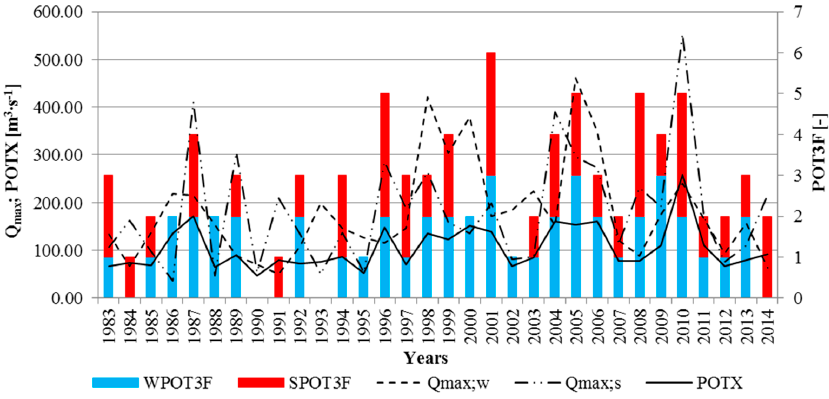
Figure 5. Q max;w , Q max;s , POTX, WPOT3F, SPOT3F and POT3F metrics for the catchment of the Wisłok at Try ń cza cross ‐ section.